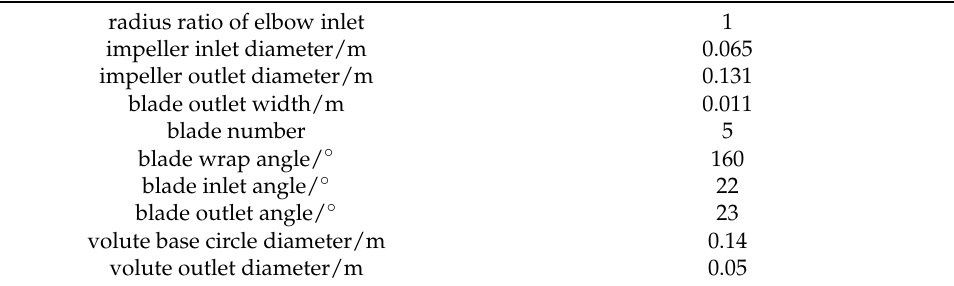
Table 2. Design parameters of centrifugal pump.